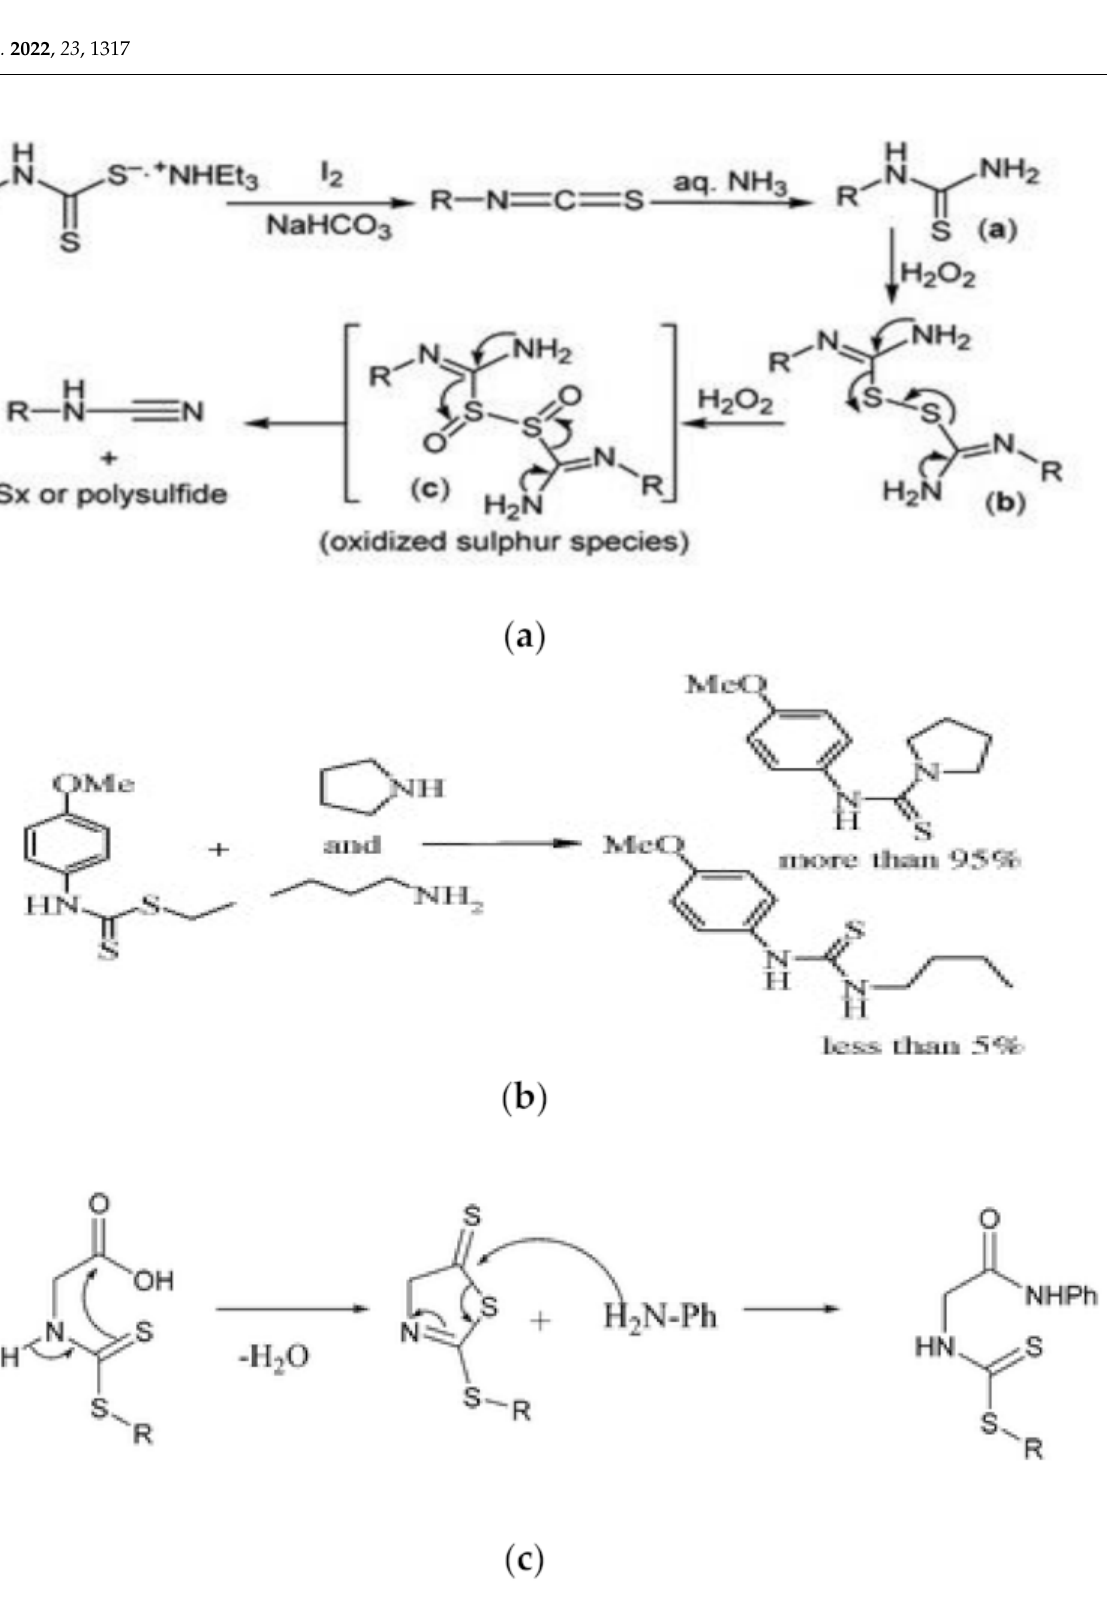
Figure 5. ( a ) Synthesis of cyanamide from dithiocarbamate. Reproduced from [71]. Copyright (2012), with permission from Taylor and Francis. ( b ) Synthesis of thiourea from dithiocarbamate and amines. Reproduced from [73]. Copyright (2009), with permission from Elsevier. ( c ) Synthesis of amide from dithiocarbamate. Reproduced from [75]. Copyright (2011), with permission from Royal Society of